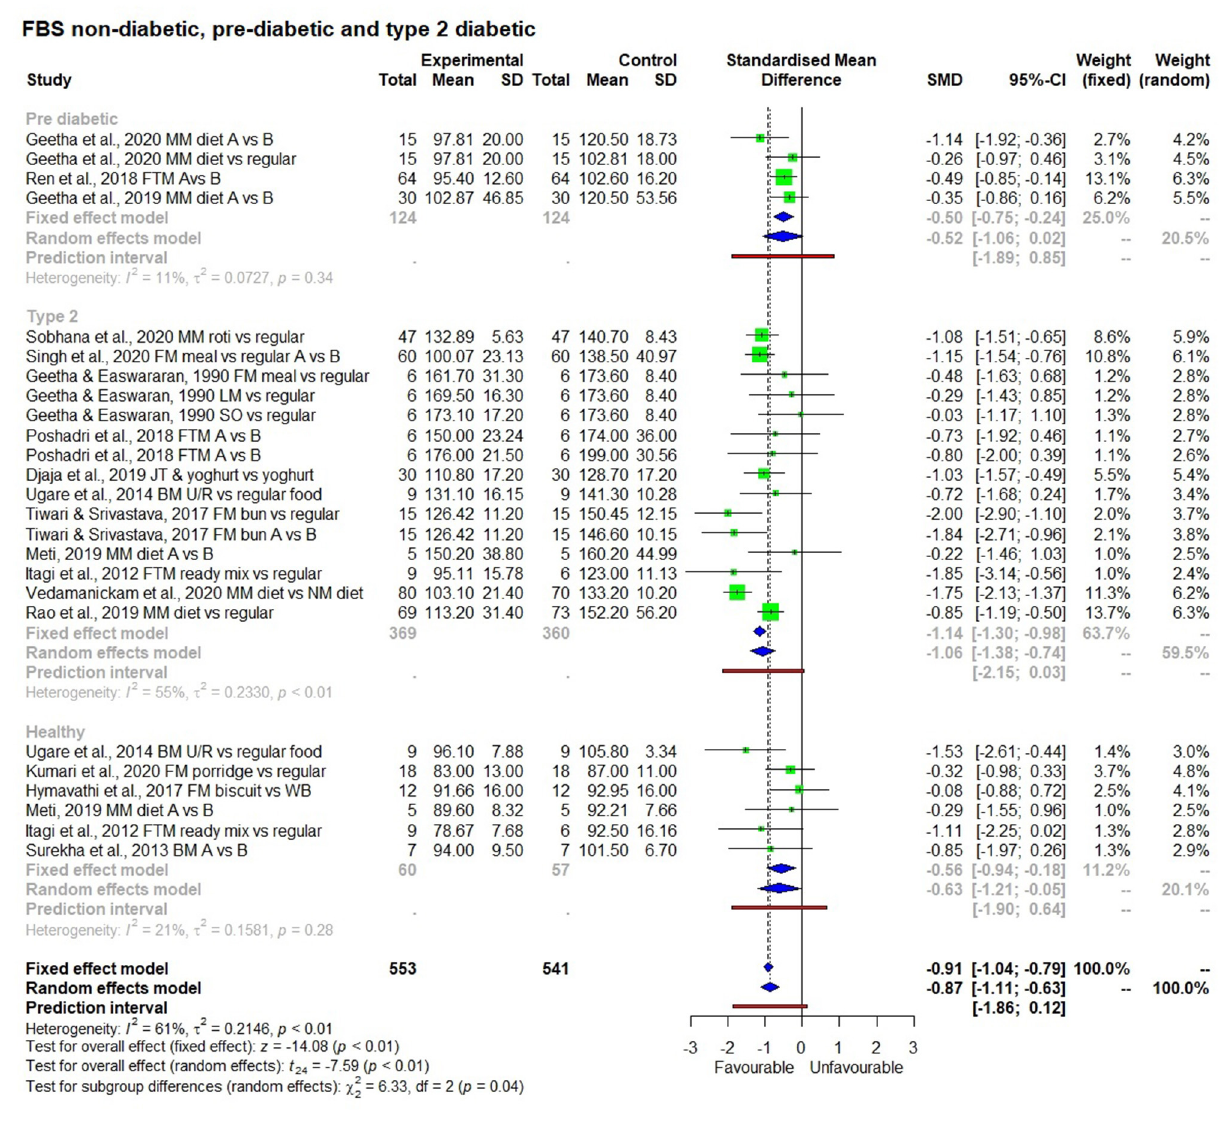
different from free unbound glucose in blood. Unlike